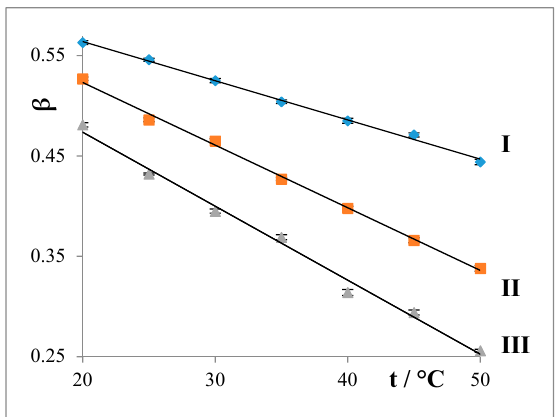
Figure 3. Dependencies of degrees of counterion bindings ( β ) on length of alkyl chain and temperature for the studied surfactants I : C12, II : C14, and III : C16, by using conductometry.